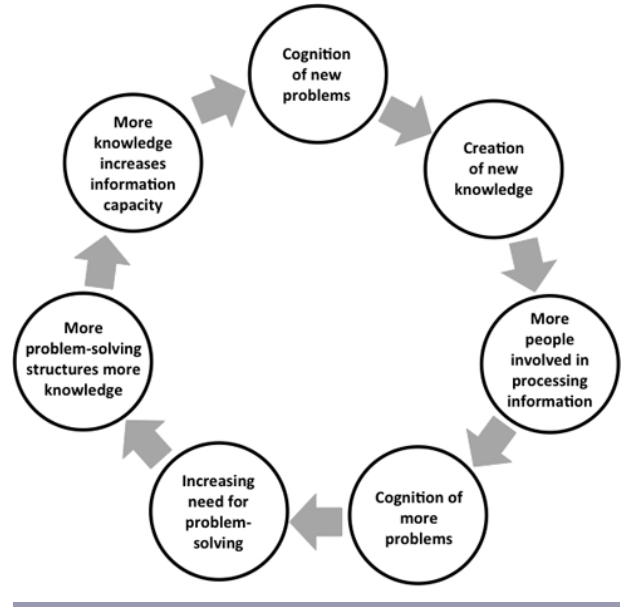
Fig. 1 . The process of knowledge